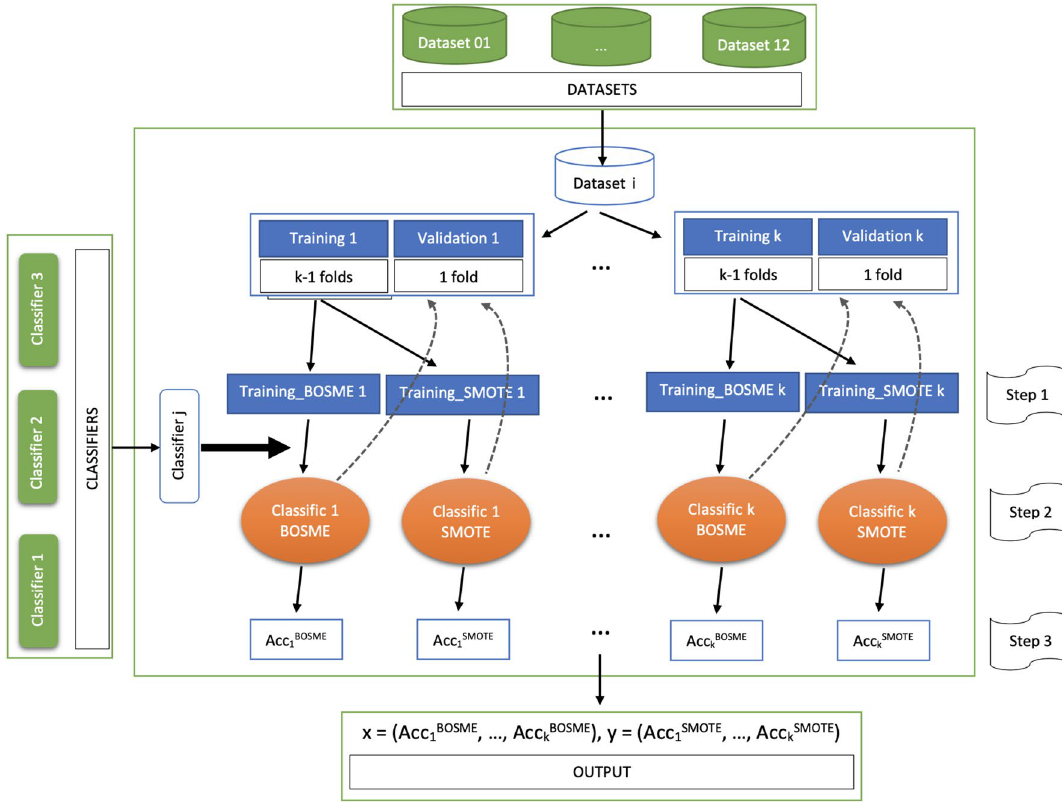
Figure 2. Implementation: Stage 1 architecture to compare BOSME with SMOTE (analogous with